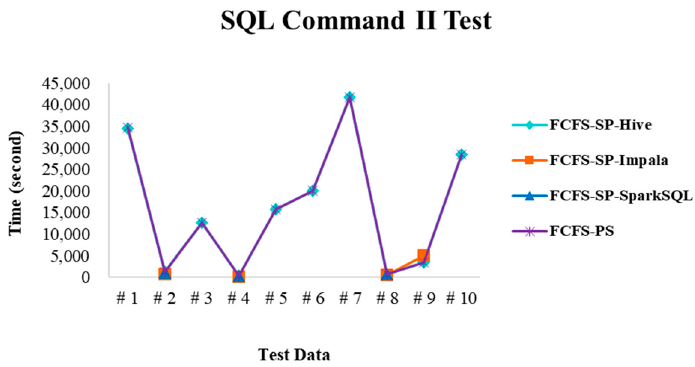
Figure 16. Execution time of SQL command II in test environment I.